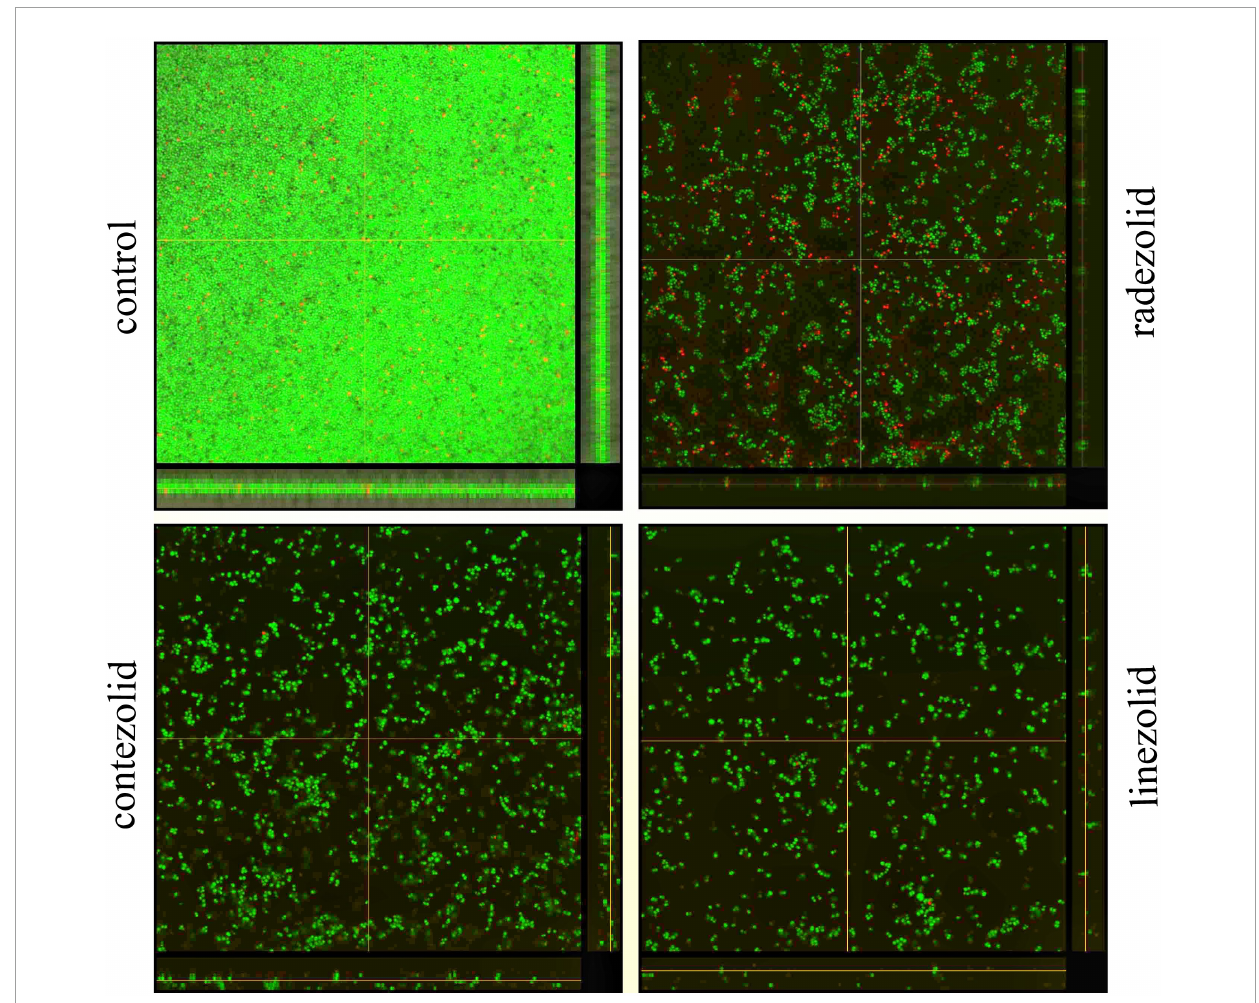
FIGURE4 The inhibitory effects of radezolid, contezolid, and linezolid on the biofilm inhibition of S. aureus by laser scanning confocal microscopy.